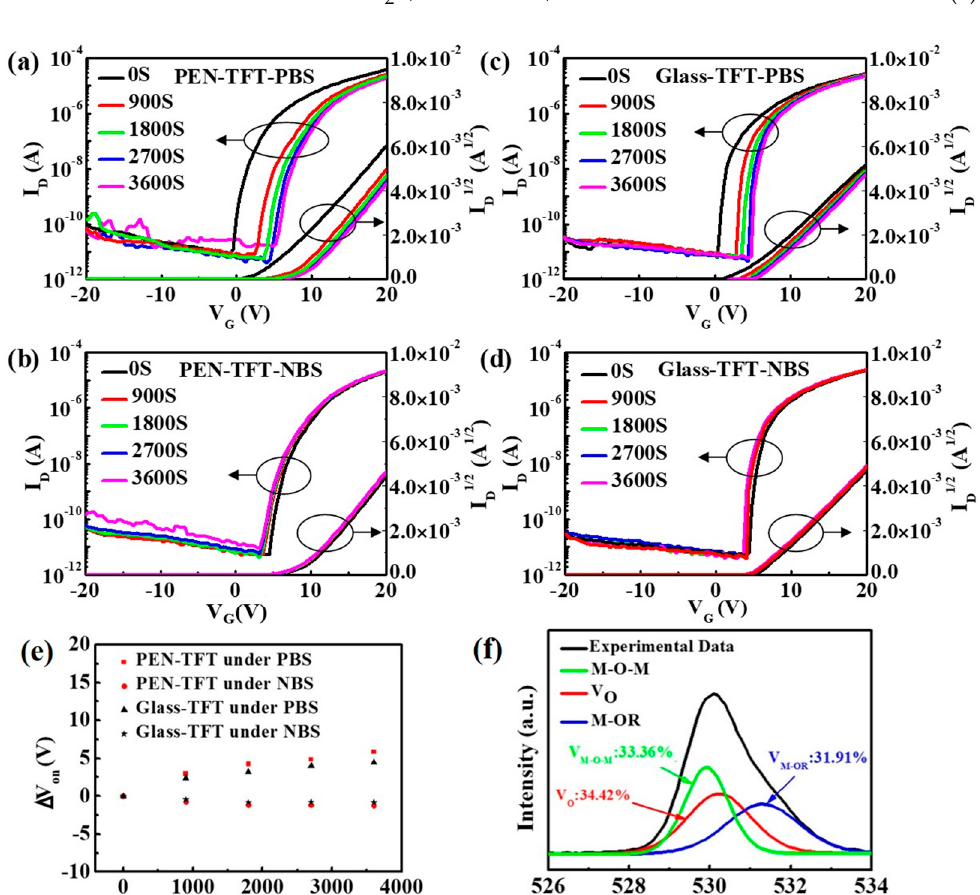
Figure 4. ( a ) PBS and ( b ) NBS results of PEN-TFT, ( c ) PBS and ( d ) NBS results of Glass-TFT, ( e ) the V on shift of these TFTs under PBS (V G = +10 V) and NBS (V G = − 10 V), ( f ) O1s photoelectron spectra (XPS) of IGZO/Al 2 O 3 film.